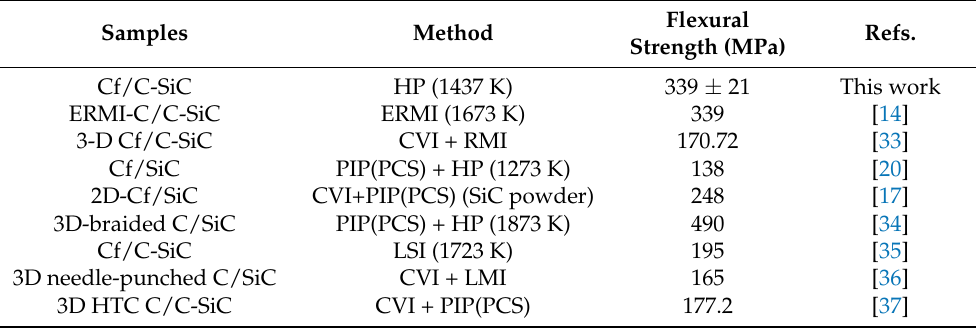
Table 5. Summary of the literature describing the Cf/C-SiC composites prepared by different preparation methods.